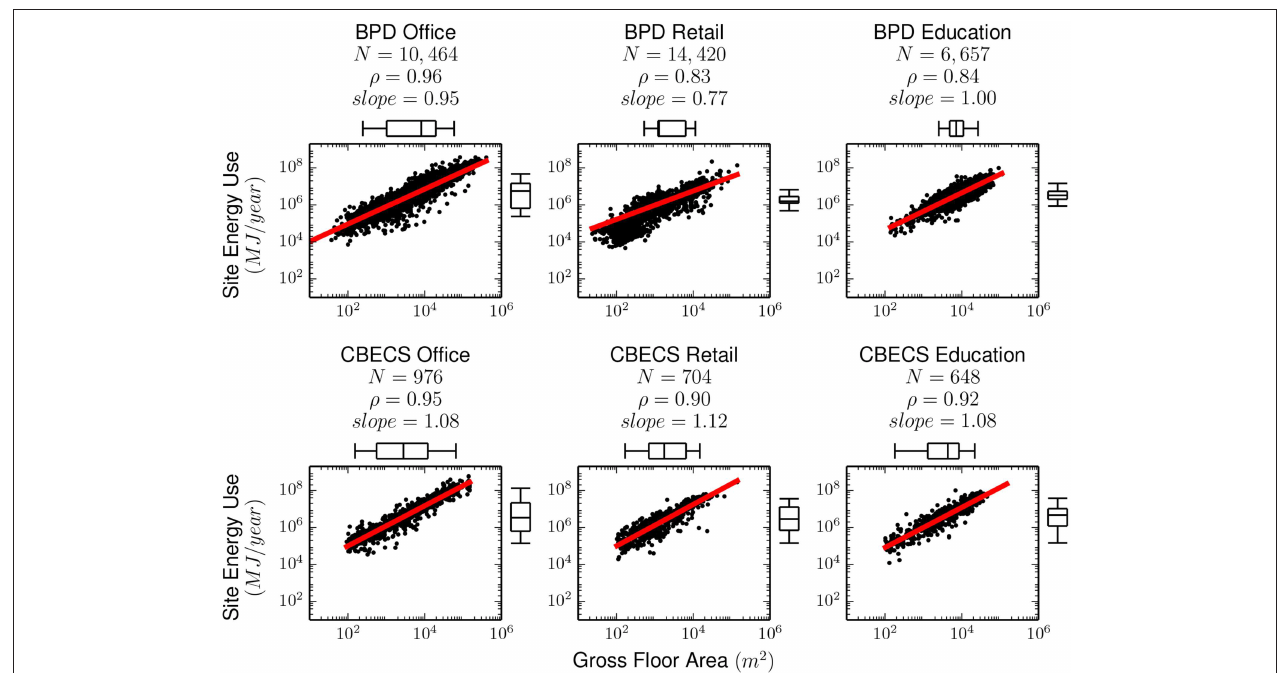
FIGURE 1 | Scatterplot showing annual whole-building site energy use ( MJ ) (vertial axis) verses gross floor area ( m 2 ) (horizontal axis) for office, education and retail buildings in the Building Performance Database (BPD) and in CBECS. Red lines denote the least squares fit. The number of observations ( N ), Pearson correlation coefficient ( ρ ) and linear regression coefficient ( slope ) for each plot is provided. Box-and-whisker plots along the vertical and horizontal axes indicate the range of reported values along each axis; whiskers denote the 5th and 95th percentiles.